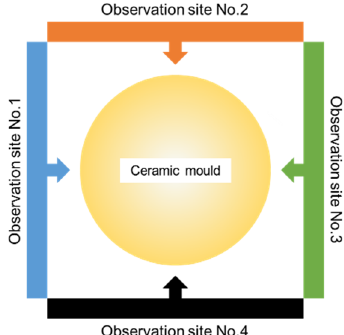
Figure 14. Observation sites of the ceramic mold with IR camera.